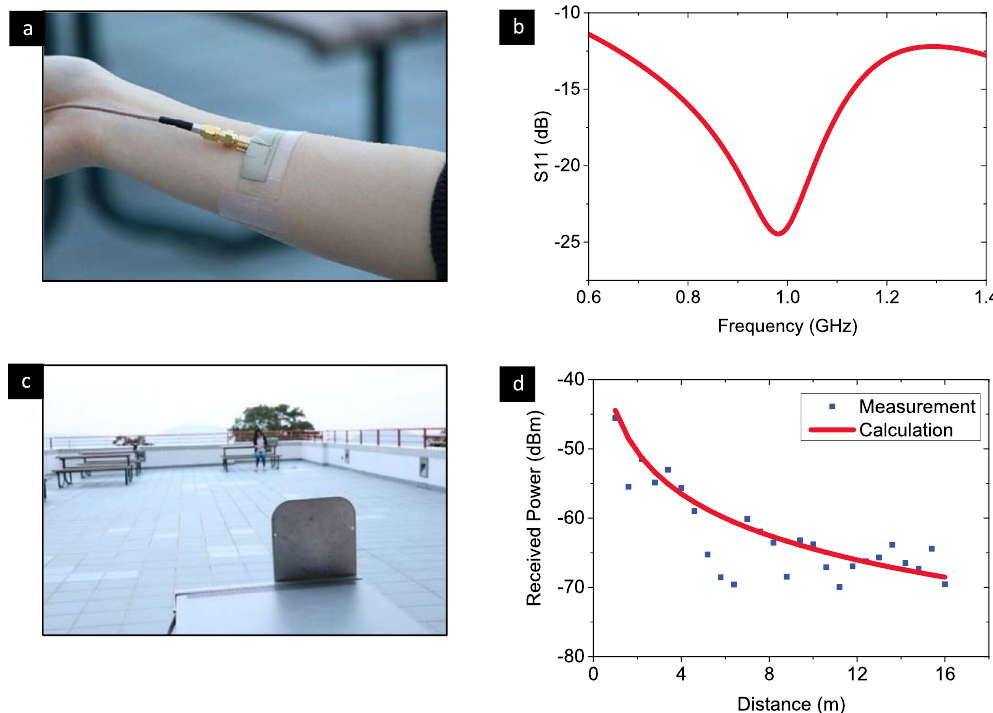
Figure 6. On-body 22 v% Ag-PDMS antenna and its transmission performance in a real application. ( a ) The antenna is directly mounted on a human arm to simulate the final end user case. ( b ) The return loss is simulated for the antenna on a human arm to ascertain its performance in real application conditions. ( c ) The test environment for far field communication showing the relationship between the distance and received power, ( d ) the data are the experimental values of power received by the on-body Ag-PDMS antenna, while the line indicates the expected variation in received power versus distance.